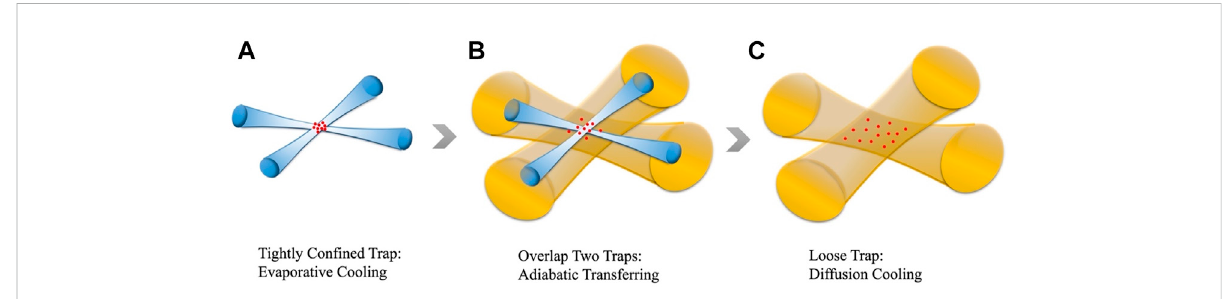
FIGURE 4 Schematic diagram of the experimental process of the two-stage cooling (TSC) scheme. (A) Atoms (red dots) trapped in the tightly con fi ned optical dipole trap formed by two thin-waisted crossed beams for evaporative cooling. (B) Adiabatic transfer of atoms from the thin-waisted optical trap (blue beams) to the thick-waisted optical trap (yellow beams). (C) Atoms are diffusively cooled in the loose optical trap while decreasing the